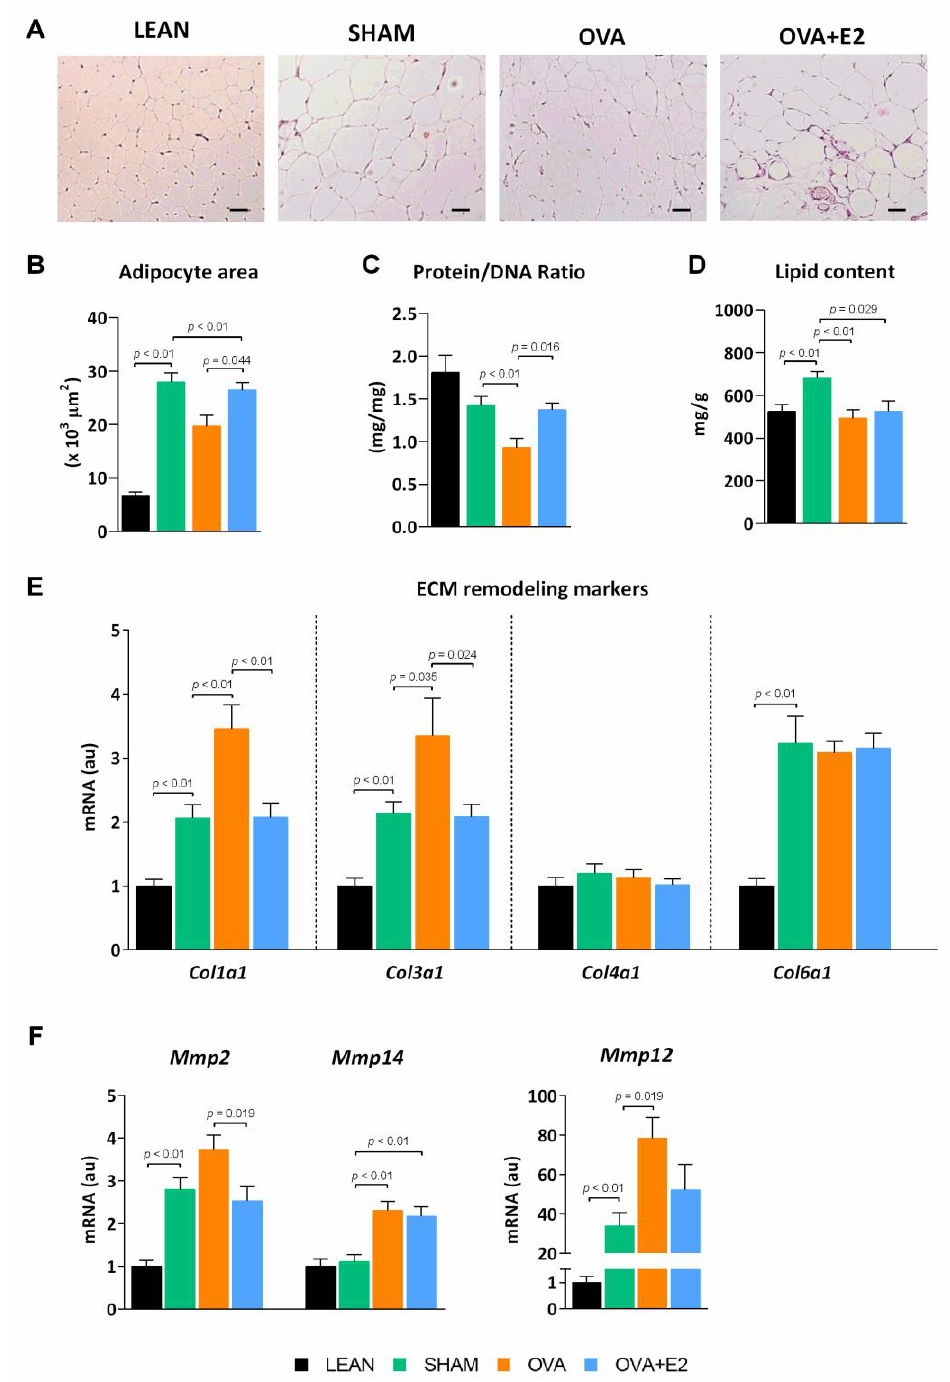
Figure 4. Ovariectomy and E2 treatment effects on WAT composition and expandability in female ZDF rats. ( A ) Adipose tissue histology. Representative slides of WAT hematoxylin-eosin stained sections (scale bar, 100 μm). ( B ) Adipocyte area. ( C ) Protein/DNA ratio and ( D ) lipid content. ( E , F ) mRNA expression of ECM remodeling markers. ECM, extracellular matrix; Col , collagen; Mmp , matrix metalloproteinase. mRNA levels were normalized to housekeeping Gapdh expression. In E and F, data are expressed in arbitrary units (au) related to LEAN group. Values are expressed as the mean ± SEM. Differences between obese-diabetic (SHAM) and control (LEAN) animals were analyzed by Student’s t -test. Differences between obese-diabetic groups with different hormonal manipulation were analyzed by One-way ANOVA with Fisher’s LSD post-hoc